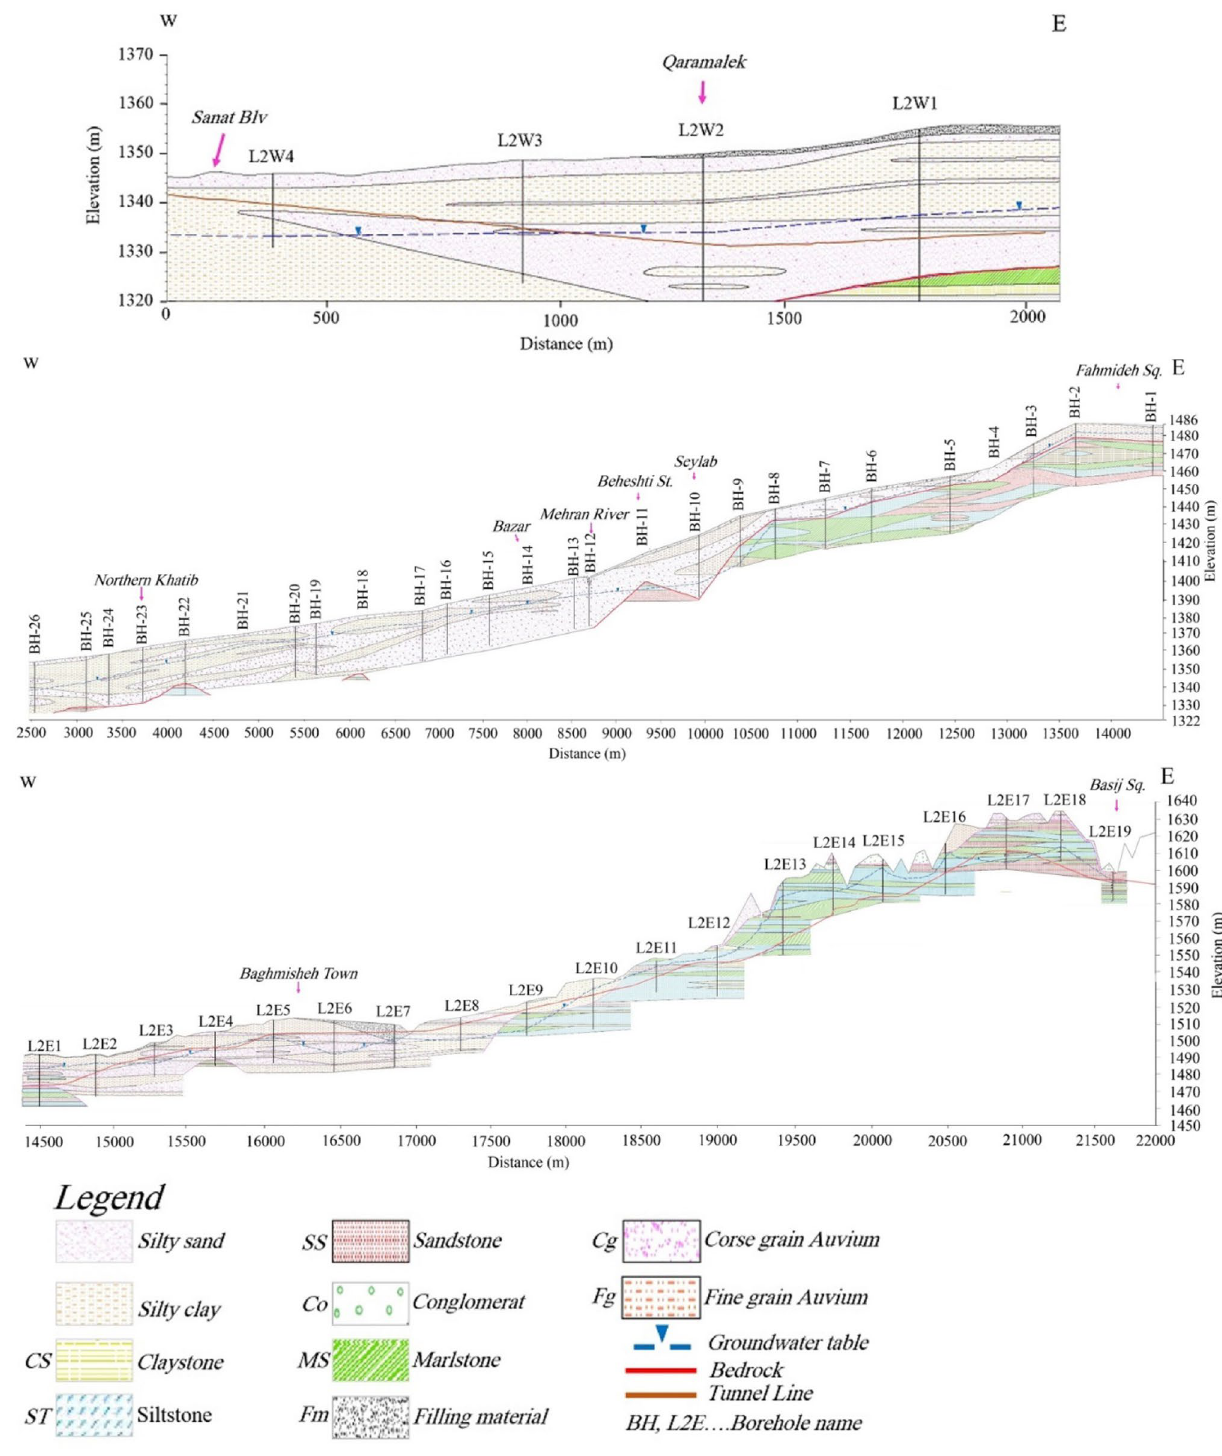
Fig. 7 Geology profile along TML2